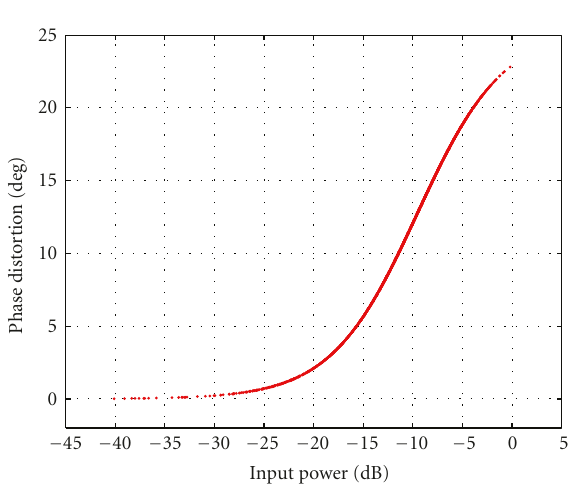
Figure 2: AM/AM characteristic.